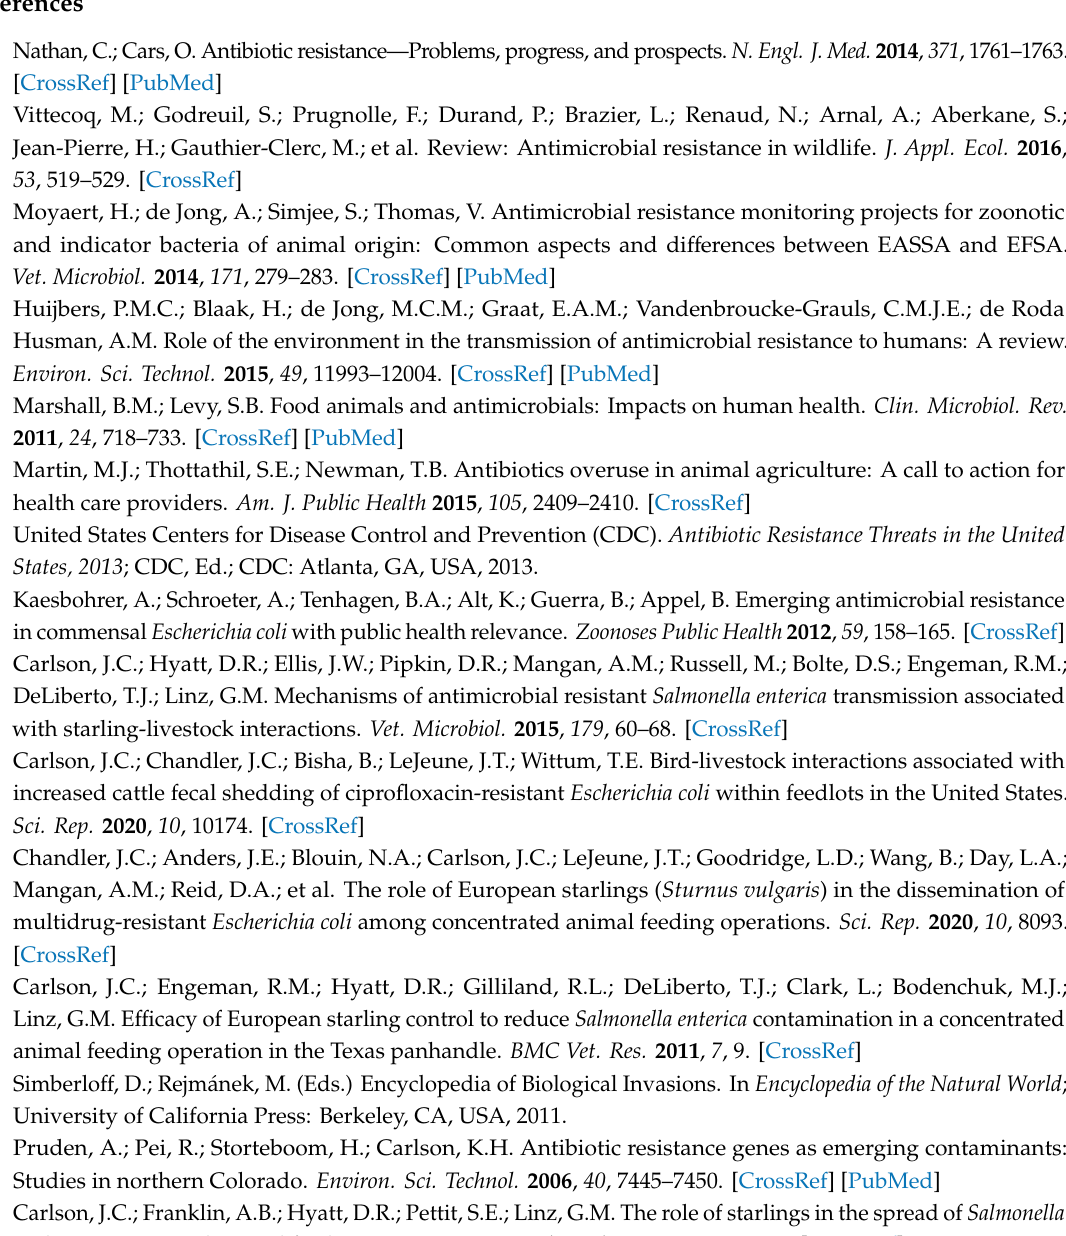
Table S1: MALDI-TOF MS identification and associated